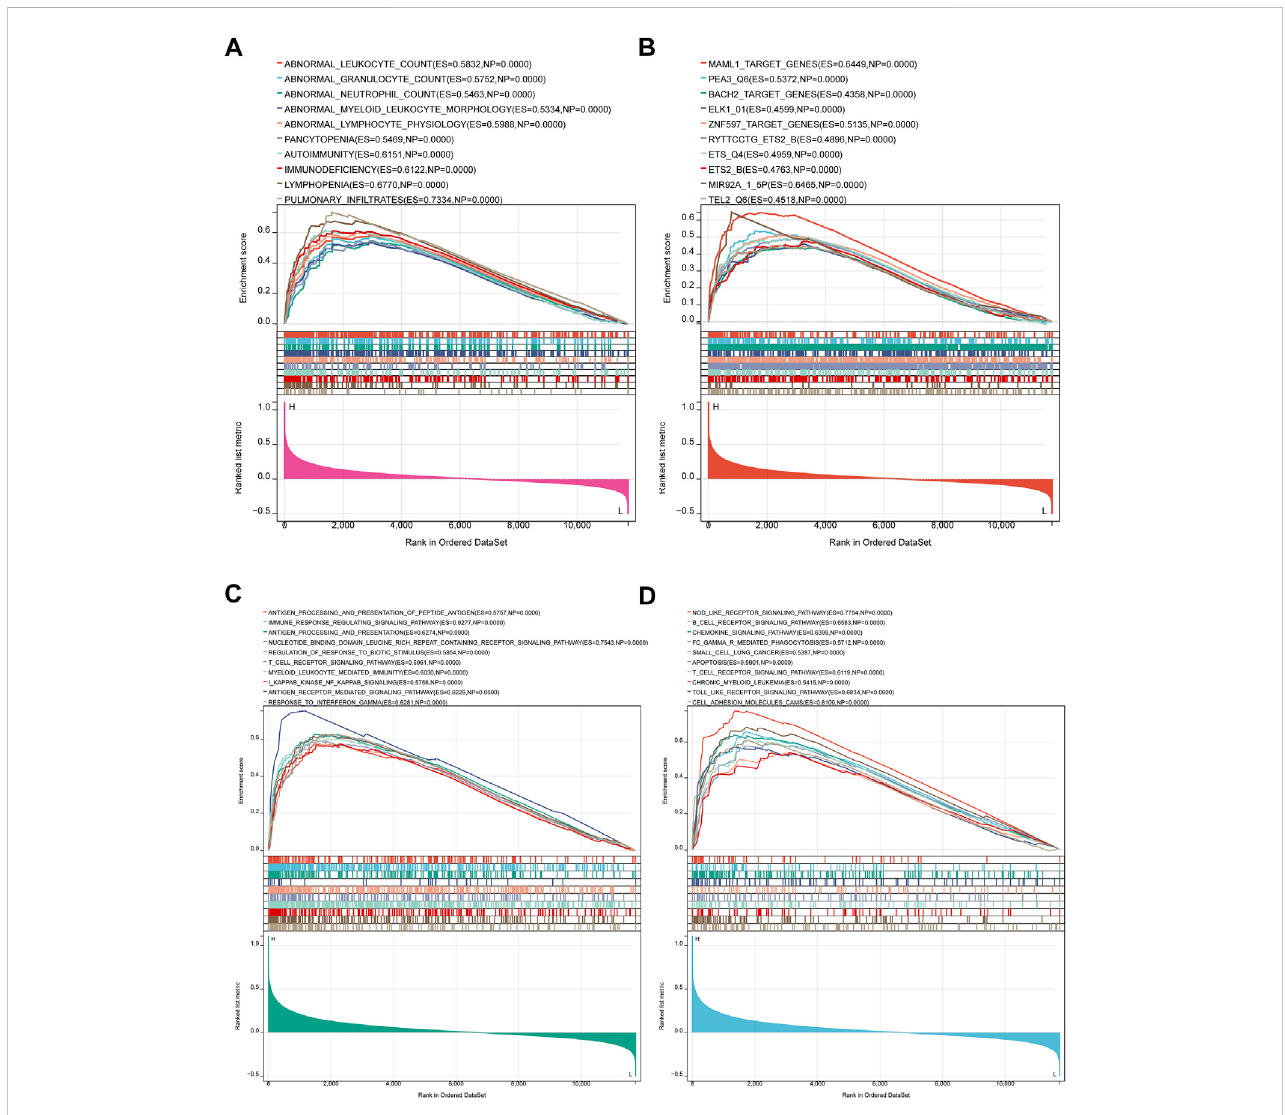
FIGURE 10 ResultofGeneSetEnrichmentAnalysisofIL10RA. (A) RegulatorytargetgenesenrichedbyIL10RA. (B) BiologicalprocessesenrichedbyIL10RA. (C) KEGG pathways by IL10RA. (D) Human phenotype Ontology enriched by